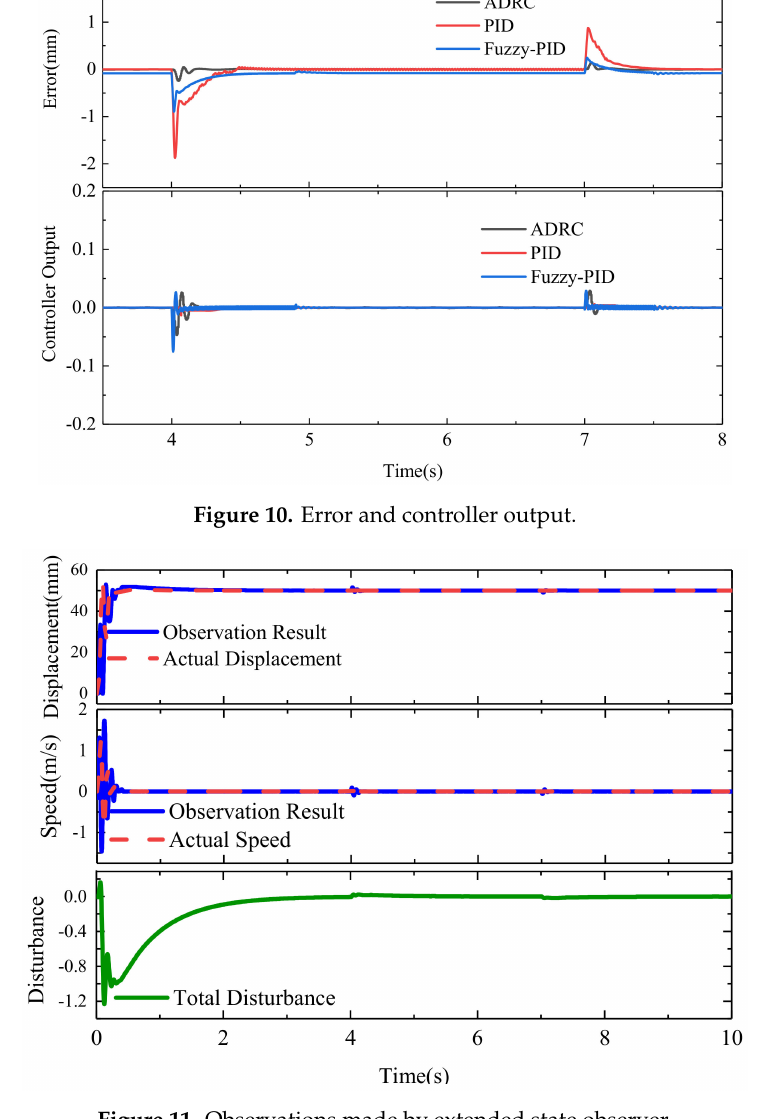
Figure 11. Observations made by extended state